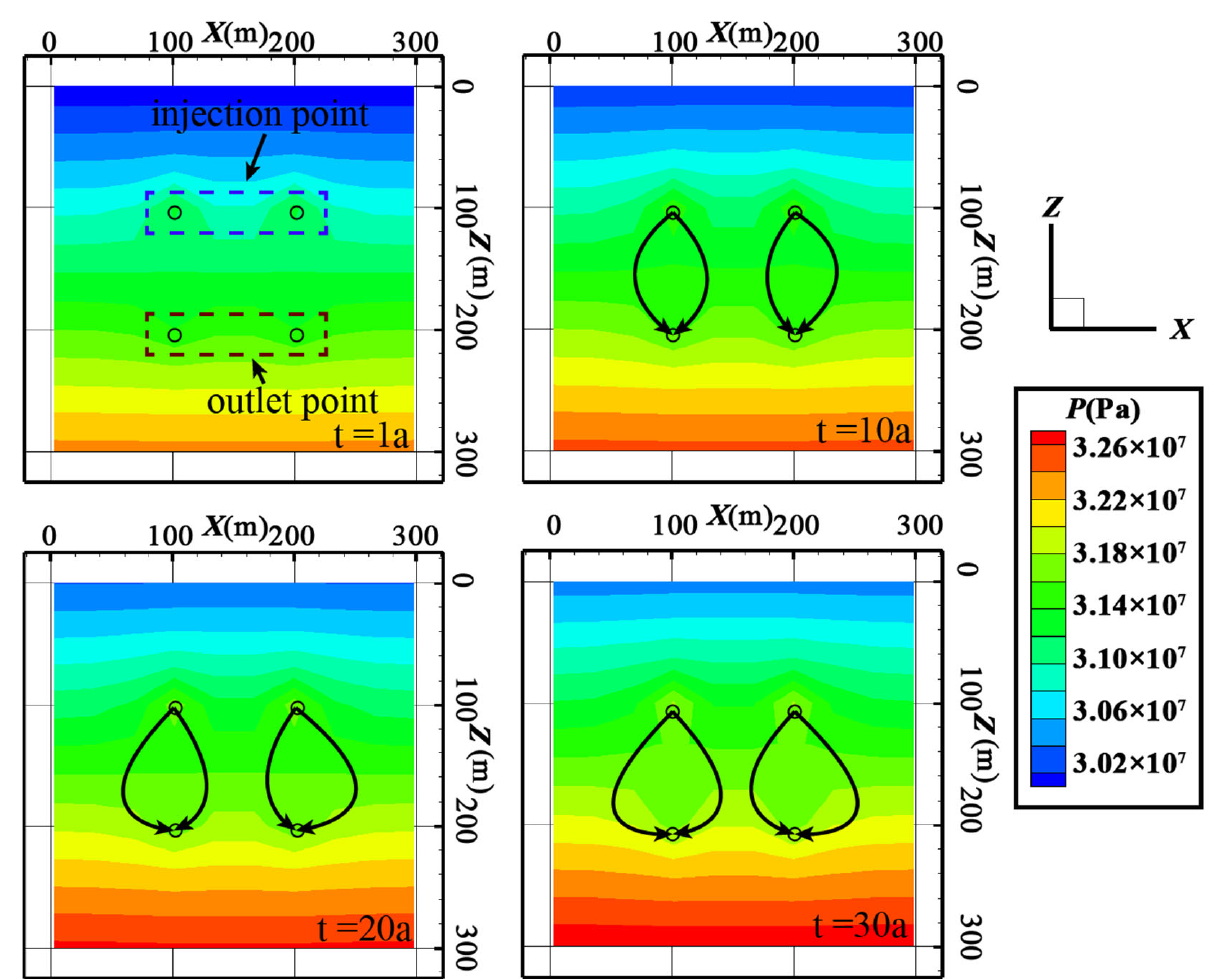
Figure 20. Pressure distribution for the double ‐ pipe heat exchange system.